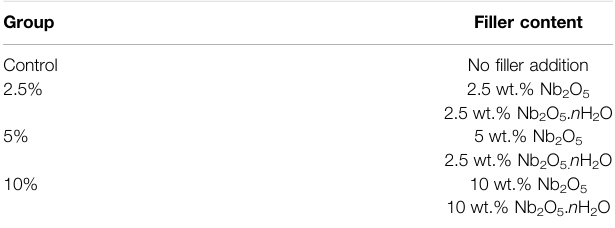
TABLE 1 | Description of the components used to design the dental adhesives according to the addition of fi lles by weight. Group Filler